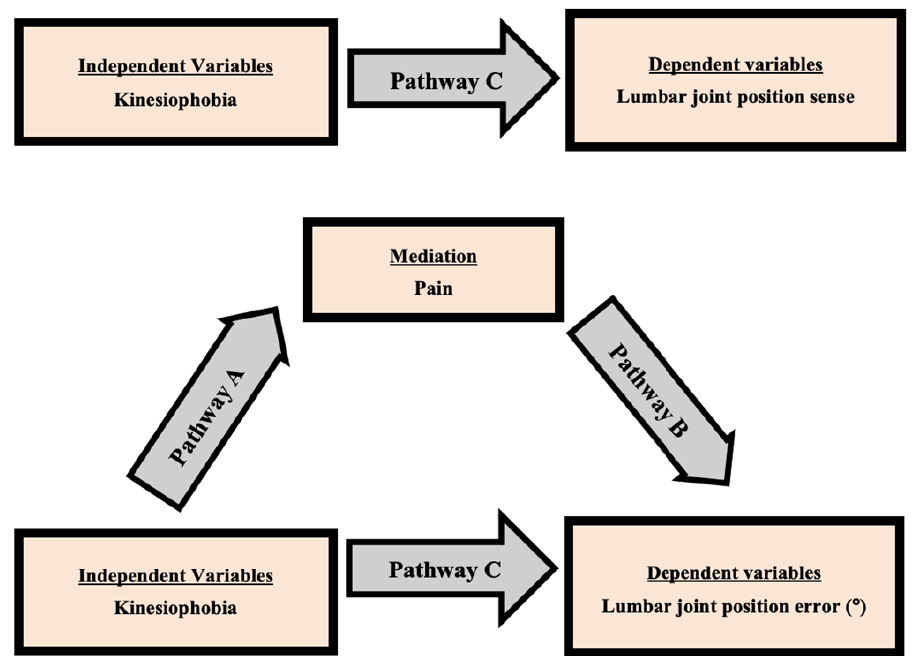
Figure 2. Model of the potential mediating effect of pain on the relationship between kinesiophobia and lumbar joint position sense.